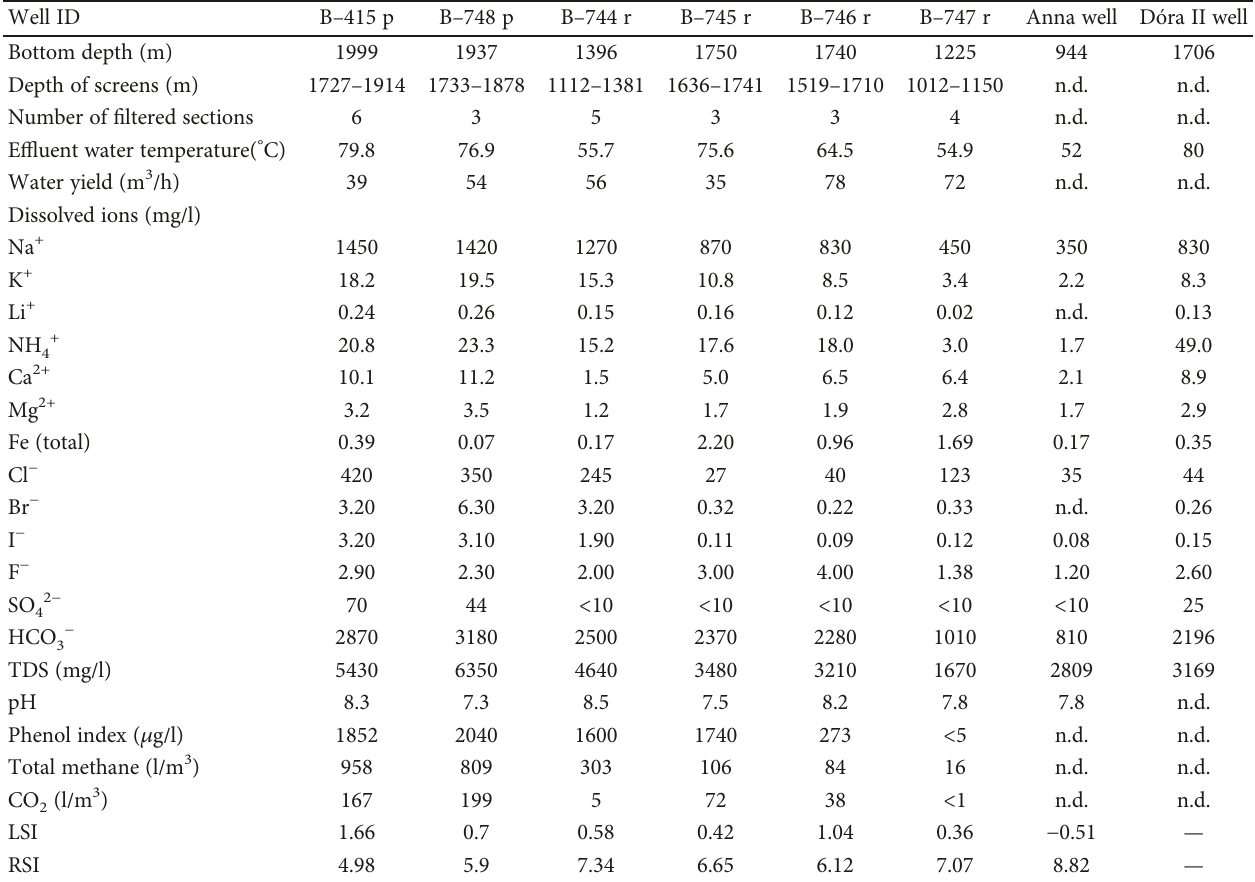
Table 2: General hydrochemical properties of the investigated production (p) and reinjection (r) wells. Data for famous spas in Szeged are also shown for comparison.